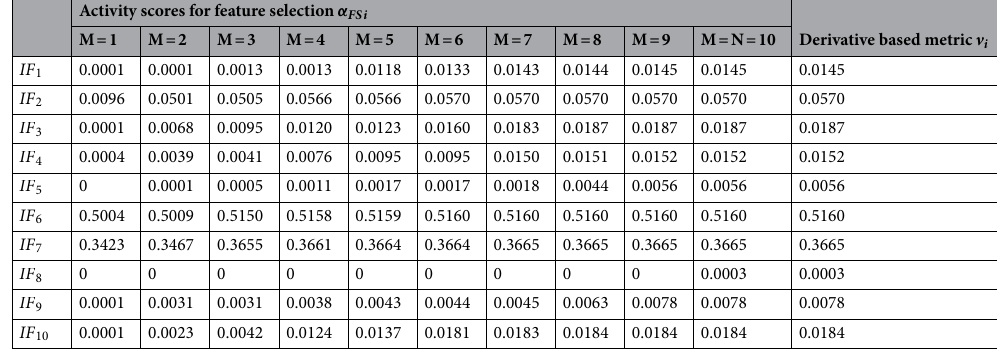
Table 4. Comparison of activity scores for feature selection and derivative based global sensitivity metric.